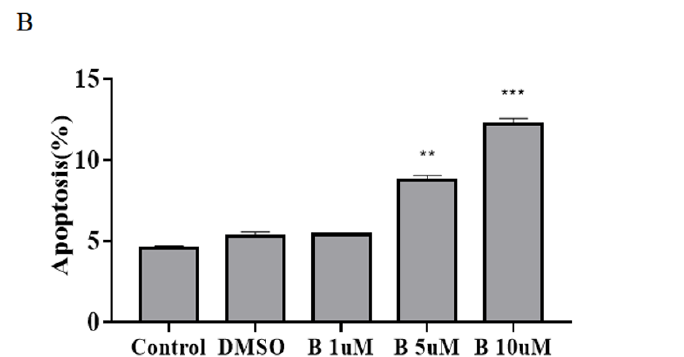
Figure 3. Bazedoxifene induces apoptosis in cervical cancer cells. ( A ) Apoptotic effects were detected using Annexin V-FITC/PI staining by flow cytometry in SiHa cervical cancer cells after 48 h. ( B ) Statistical analysis of the percentage of cell apoptosis. Bars indicate mean ± standard deviation of three independent experiments performed in triplicate (**, p < 0.01; ***, p < 0.001 vs. control). B: Bazedoxifene.